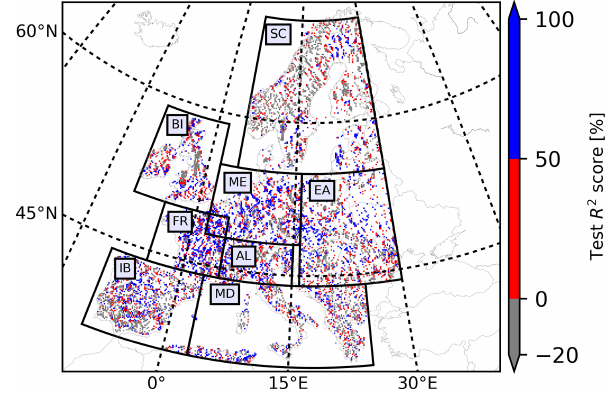
Figure 7. Map of test R 2 scores achieved by the proposed LSTM networks in the PRUDENCE